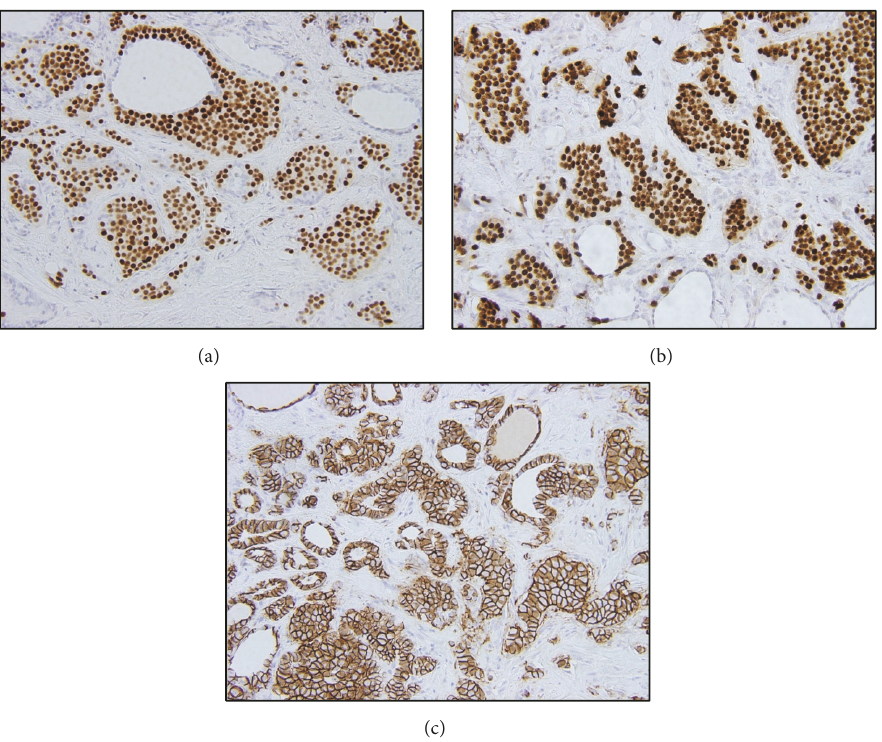
Figure 2: The tumor cells express nuclear positivity for ER ((a), x200) and GATA3 ((b), x200) immunohistochemistry, and diffuse membranous staining with e-cadherin ((c),